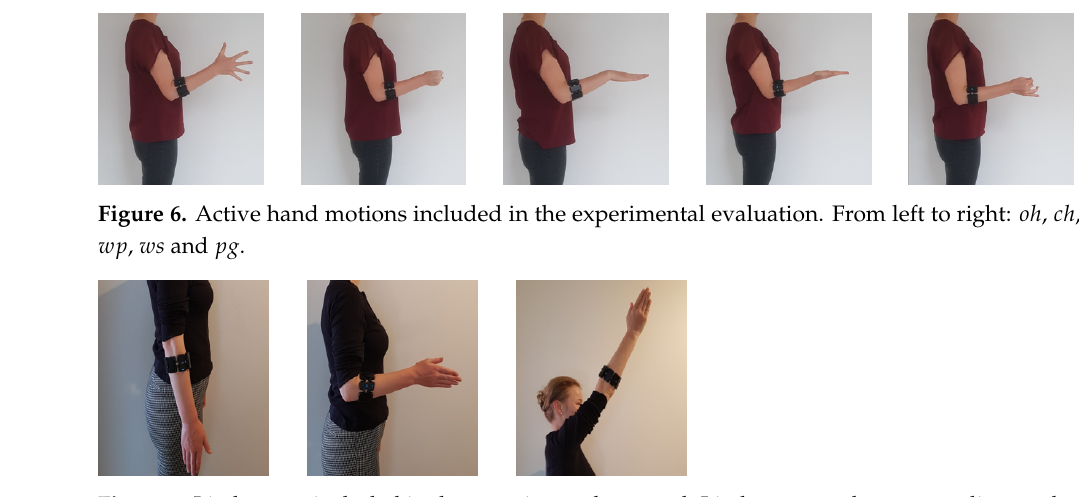
Figure 7. Limb poses included in the experimental protocol. Limb poses and corresponding angles from left to right: pose 1 ◦ —0 ◦ , shoulder and elbow flexion, pose 2 ◦ —90 ◦ , elbow flexion, pose 3 ◦ —135 ◦ , shoulder flexion.